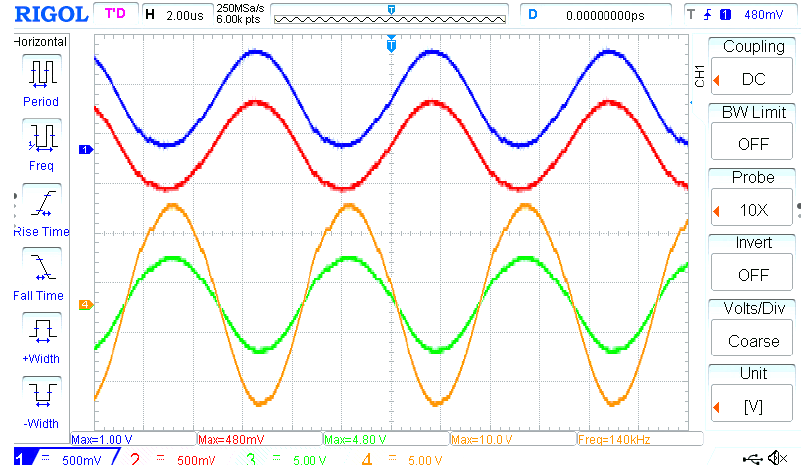
Figure 13. Primary side circuit voltage waveforms; blue curve (CH_1) shows the DDS voltages before filtering, red curve (CH_2) presents the signal after filtering, green curve (CH_3) output of the voltage amplifier, orange curve (CH_4) current amplifier output voltage.